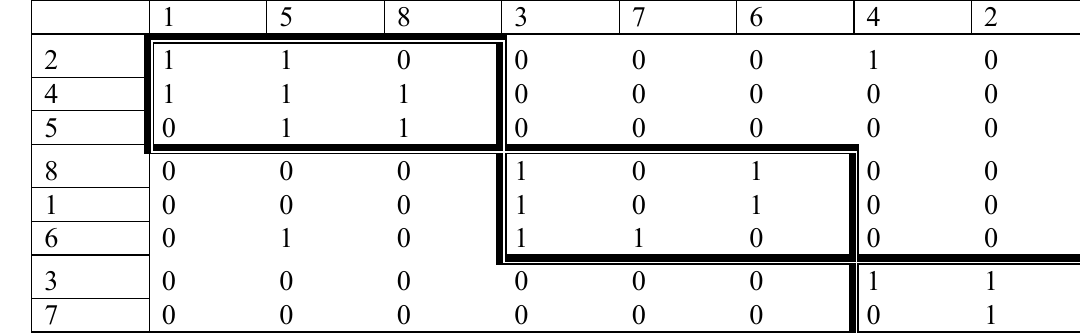
Final solution matrix Z for problem